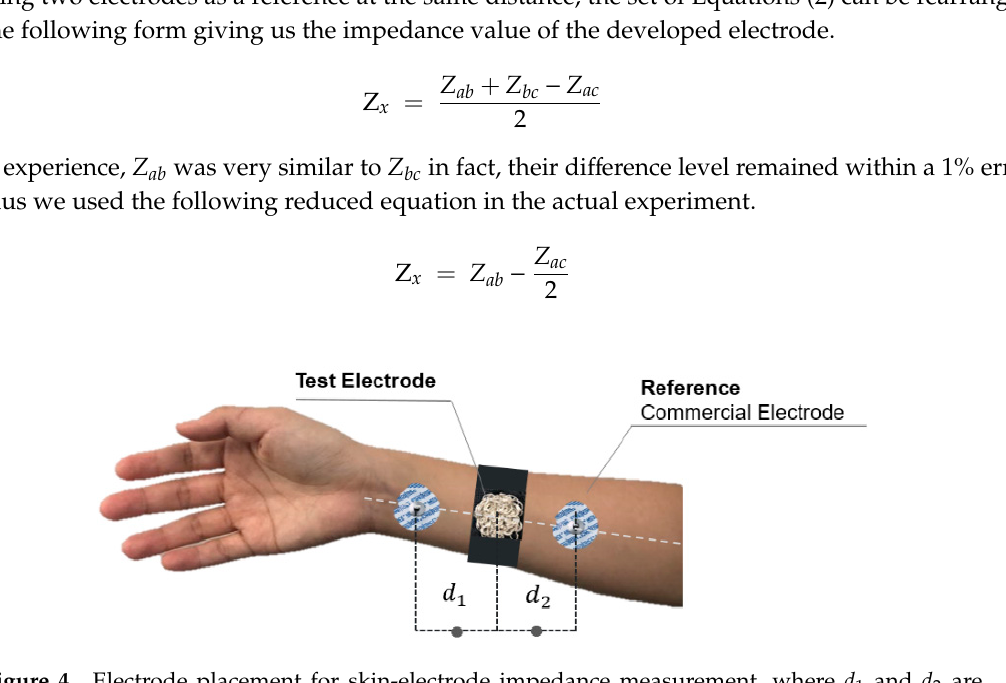
Figure 4. Electrode placement for skin-electrode impedance measurement, where d 1 and d 2 are considered as equal distance between the embroidered electrode and the commercial electrodes.